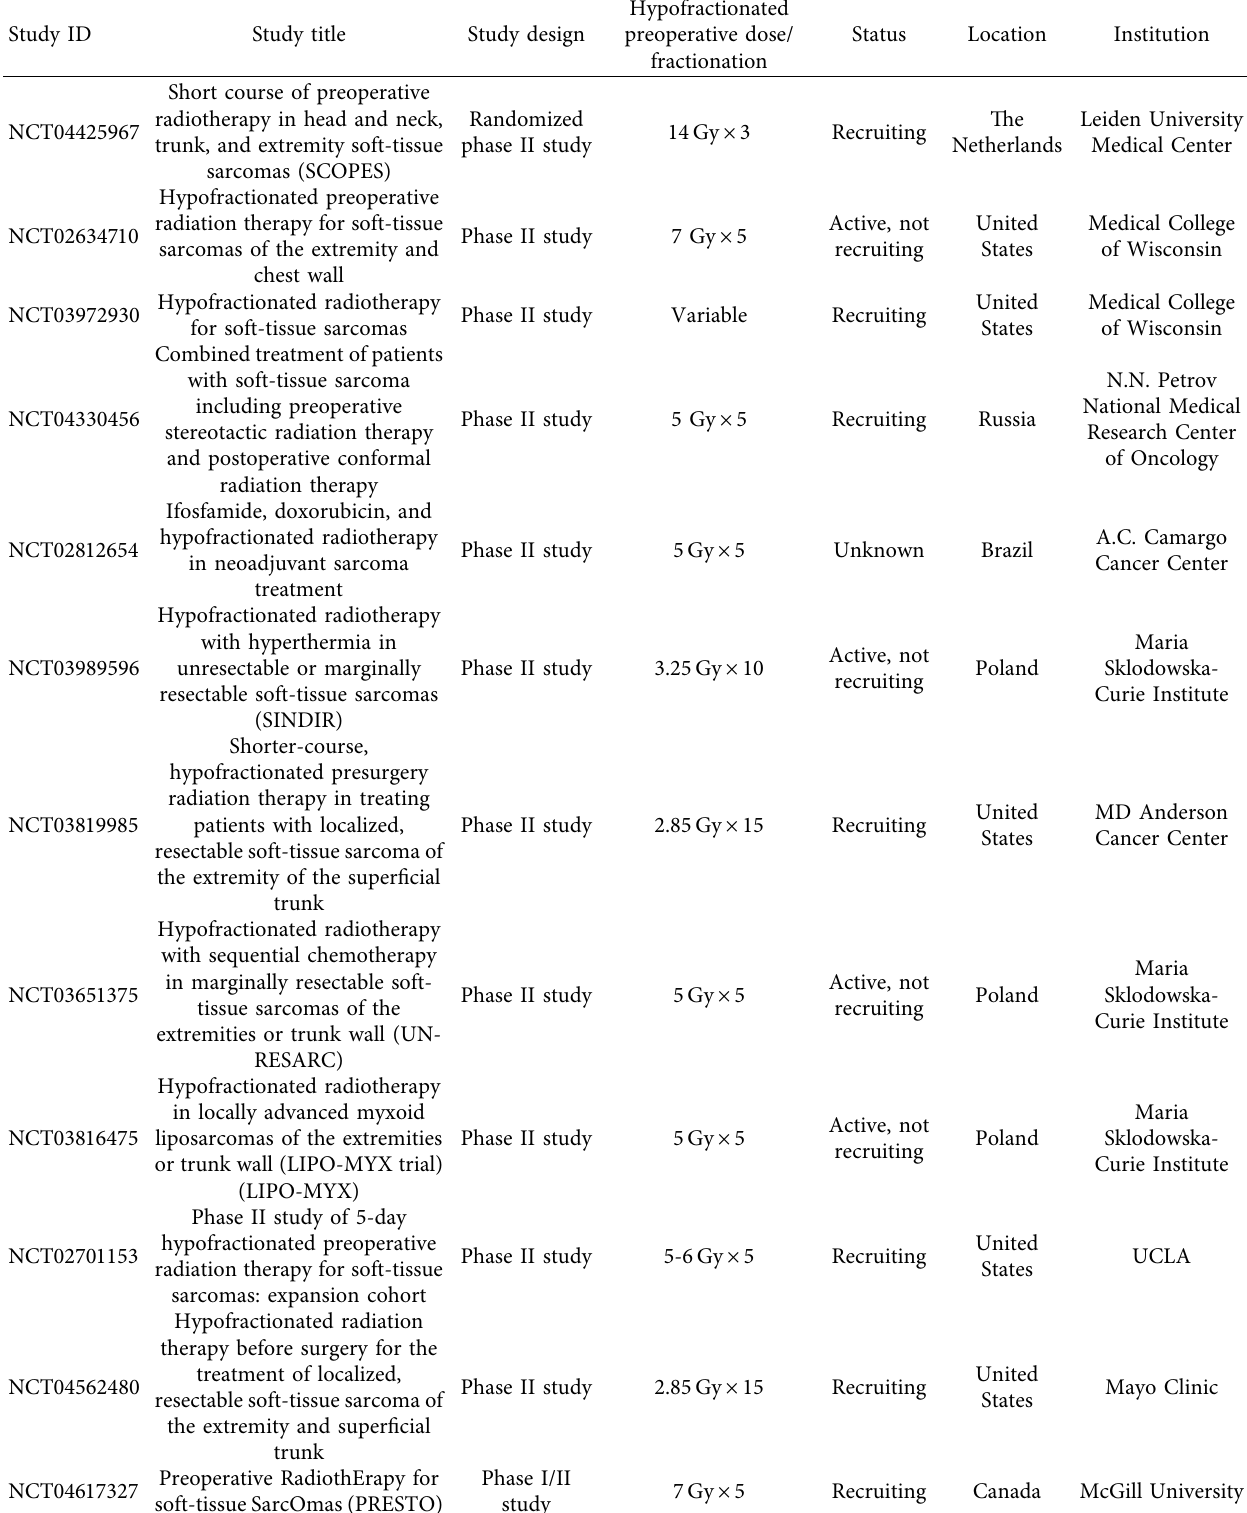
Table 1: Ongoing preoperative hypofractionated